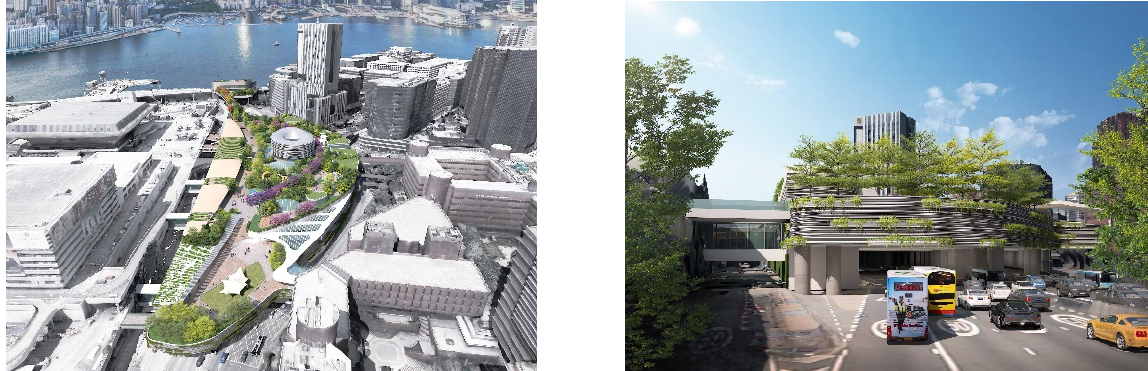
Figure 7. Green Deck Project lead by the Hong Kong Polytechnique University in the Cross ‐ Harbor Tunnel (Kowloon, Hong Kong). This project combines harmonically green roofs and walls with architectural mortar using TiO 2 and recycled glass for air ‐ purifying purposes [56].